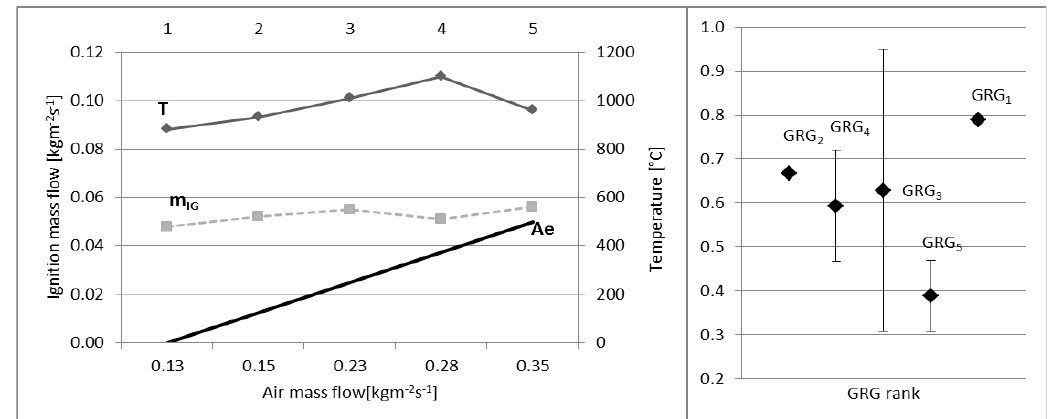
Figure 8. Air mass flow rate effect on the ignition mass flow rate and the front temperature of the olive stone (os), and the GRG